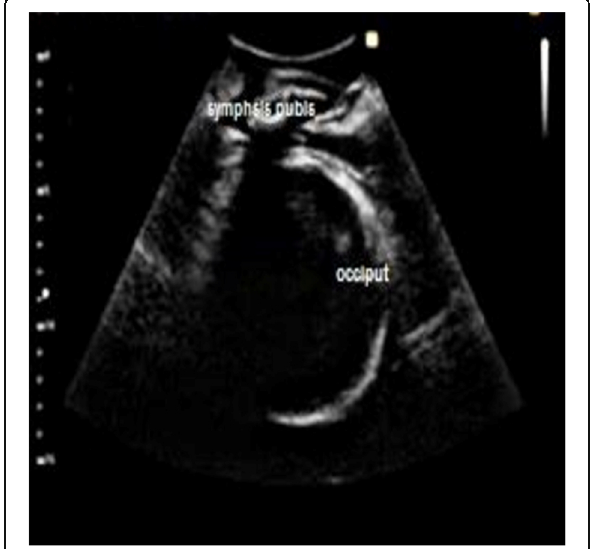
Kendall ’ s rank correlation. Bland-Altman method was used to examine agreement between US and VE as regards the quantification of cervical dilatation and head rotation. The differences between the two methods were plotted (on the Y -axis) against the averages of the two methods (on the X -axis). Horizon- tal lines were then drawn at the mean difference (bias), and at the limits of agreement, which are defined as the mean difference ± 1.96 times the standard